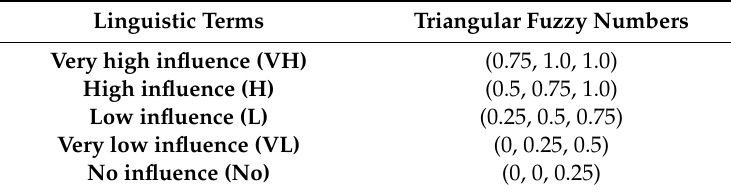
Figure 1. Membership function of triangular fuzzy numbers. Table 2. Fuzzy linguistic scale